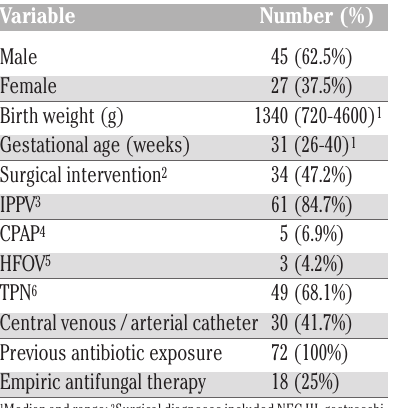
Table 1. Sample characteristics (n=72).